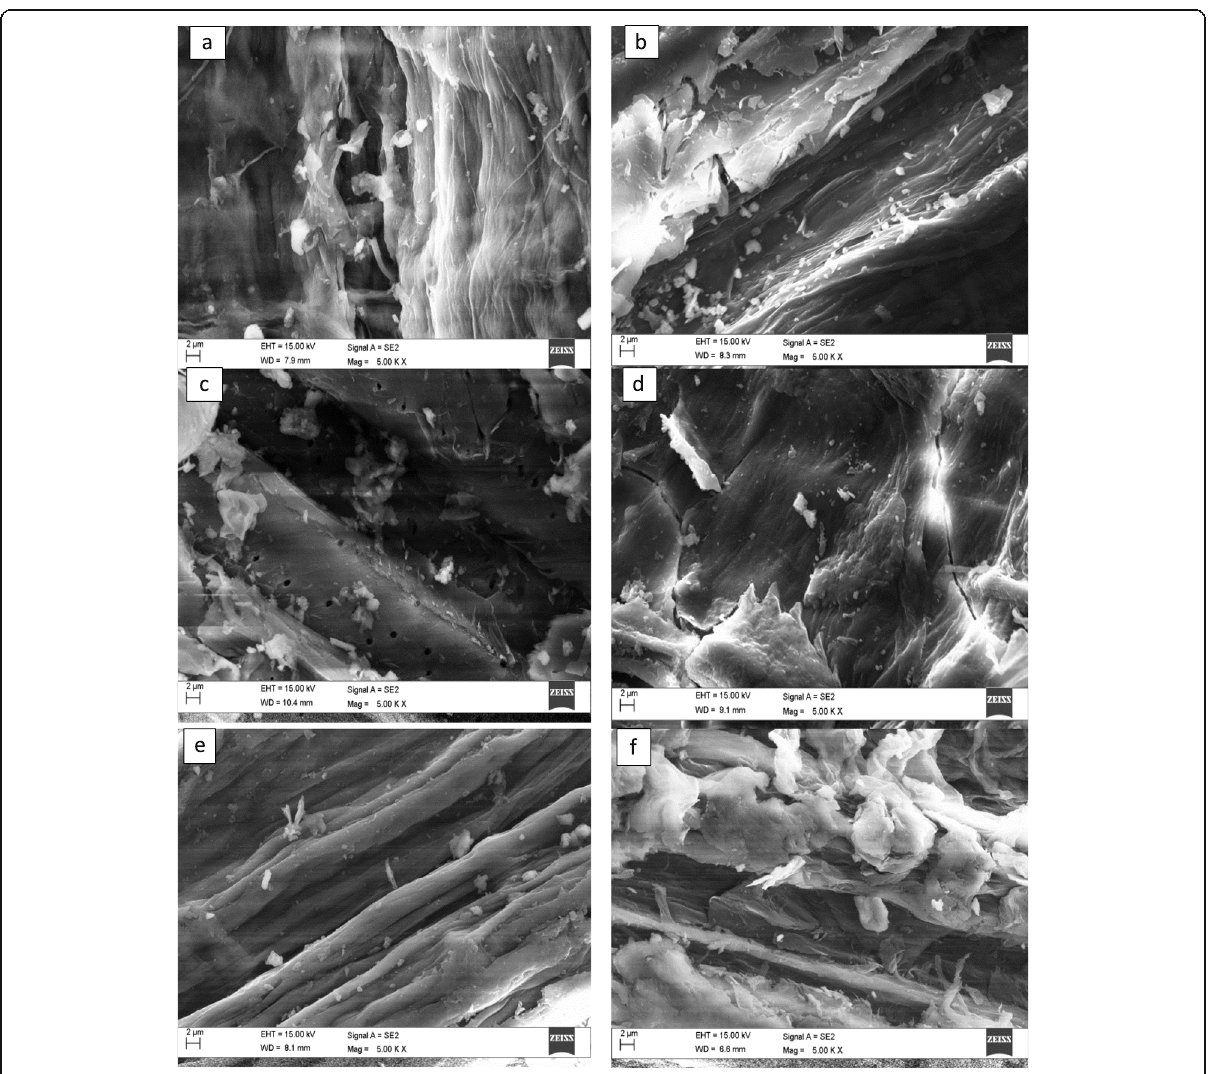
Fig. 2 Electron micrograph of rice straw particles at × 5000 magnification. a Untreated (raw). b 1% NaOH treated. c 3% NaOH treated. d 5% NaOH treated. e 7% NaOH treated. f 10% NaOH treated